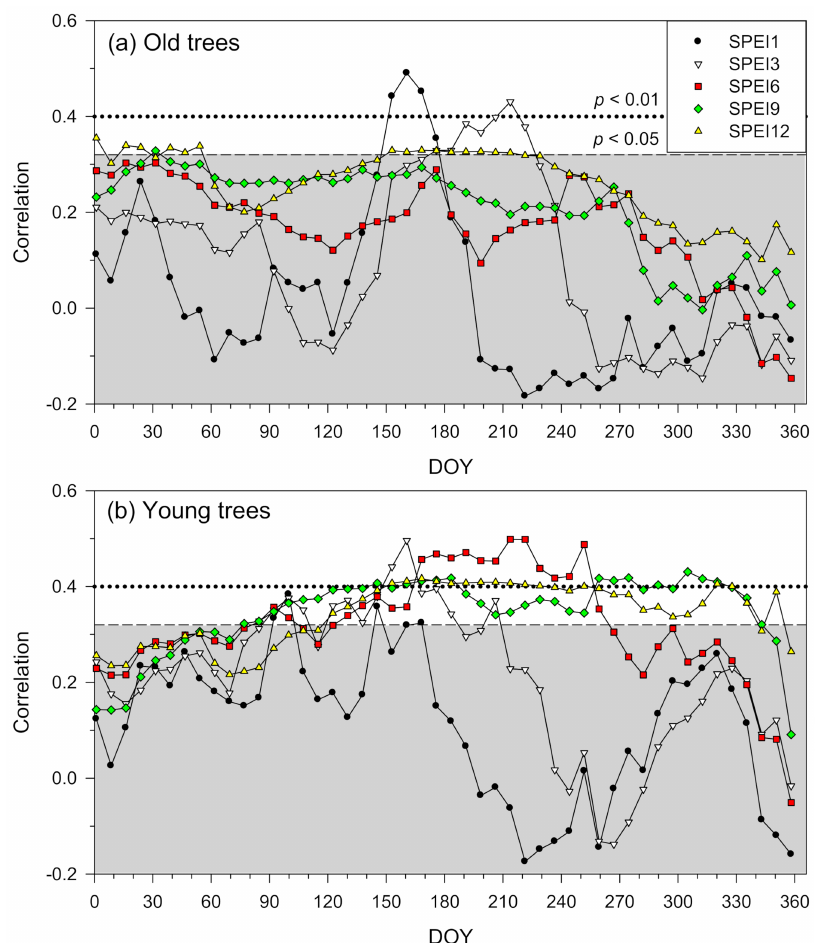
Figure 5. Correlations between the ring width indices of old ( a ) and young ( b ) trees and the weekly Standardized Precipitation-Evapotranspiration Index (SPEI) drought index calculated at 1- (SPEI1), 3- (SPEI3), 6- (SPEI6), 9- (SPEI9) and 12-month (SPEI12) resolutions. The x-axis indicates the day of the year (DOY). Horizontal dashed and dotted lines show the 0.05 and 0.01 significance levels, respectively. Significant values are those located outside the grey